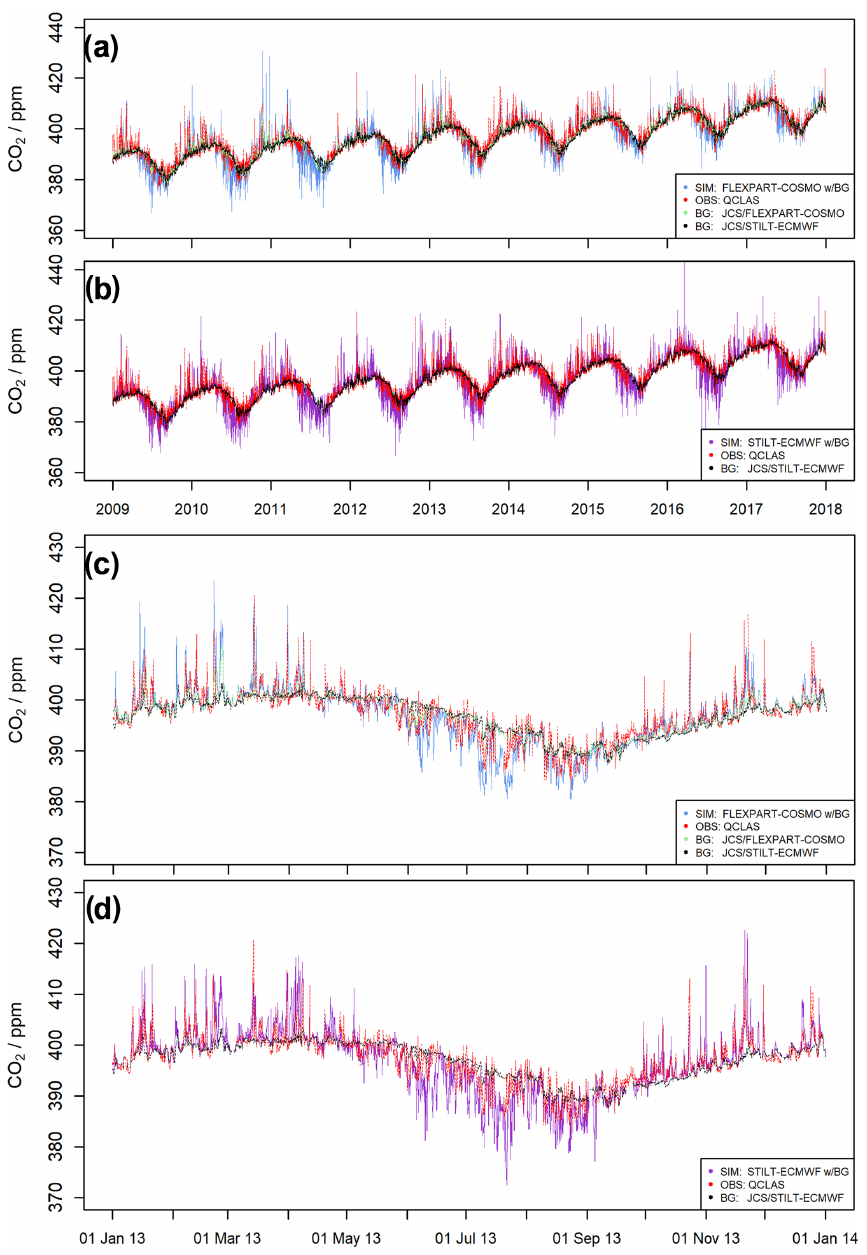
Figure 3. Time series of CO 2 .total simulations with (a, c) FLEXPART–COSMO and (b, d) STILT-ECMWF compared to hourly observations. (a, b) 2009–2017 (tick marks indicate January of each year), (c, d) 2013 (JCS-based background is detailed in Fig. S3a).